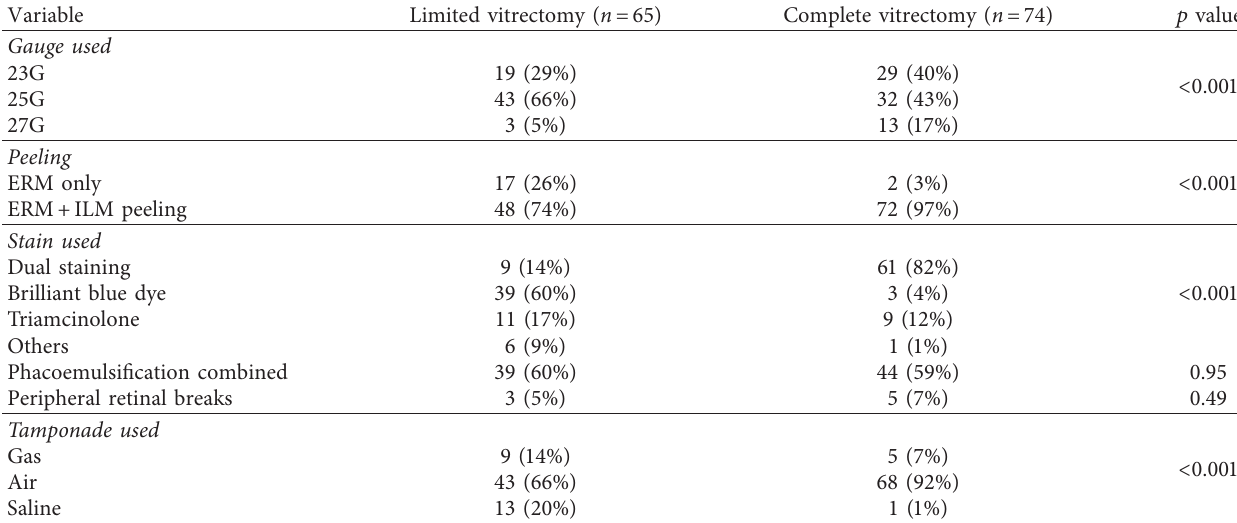
Table 2: Comparison of intraoperative characteristics in limited versus complete vitrectomy group.